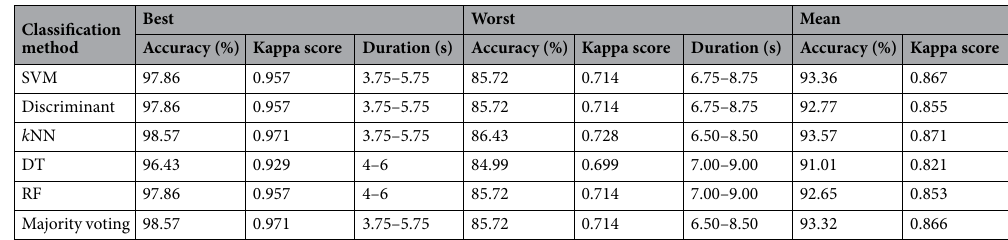
Table 7. Classification accuracy and kappa score results for two-second segments using Stockwell transform for datset II–III.